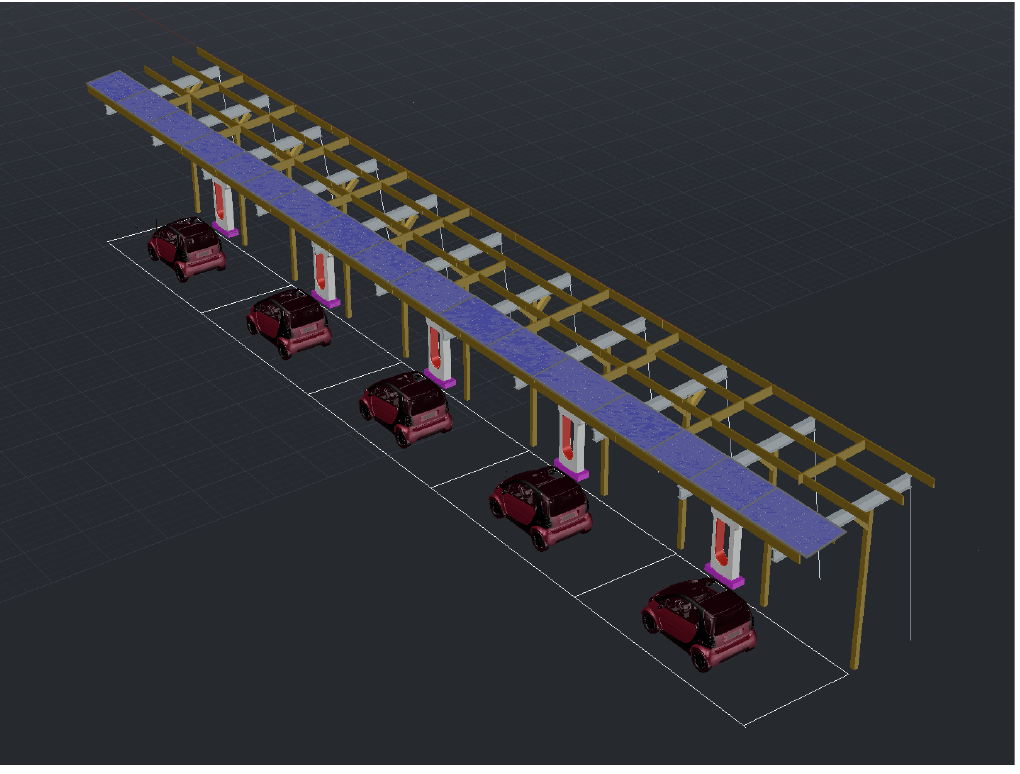
Figure 10. Final cantilevered system. Table 7. Cost per W for each system in CAD.